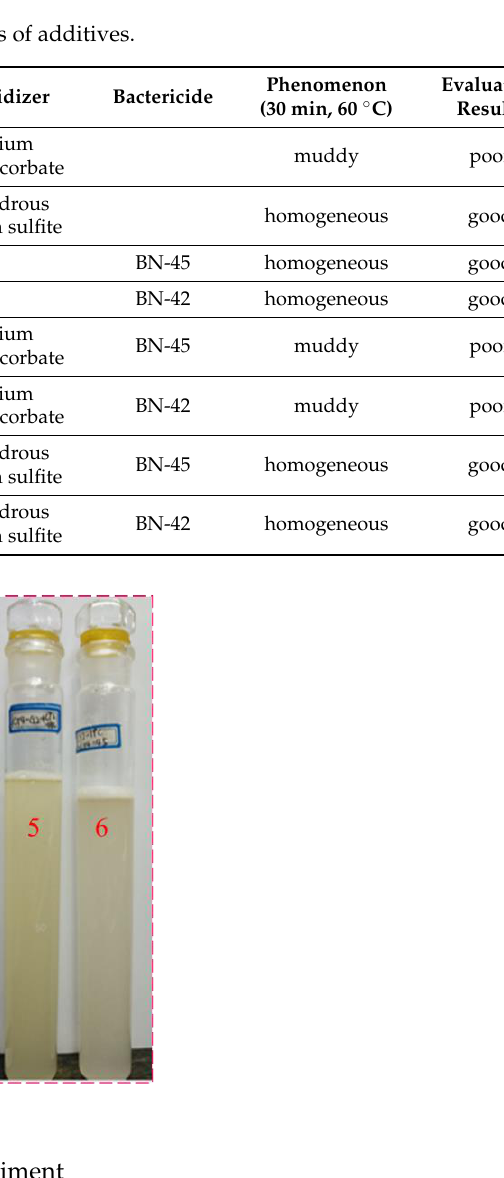
Table 4. Compatibility scheme and results of additives.